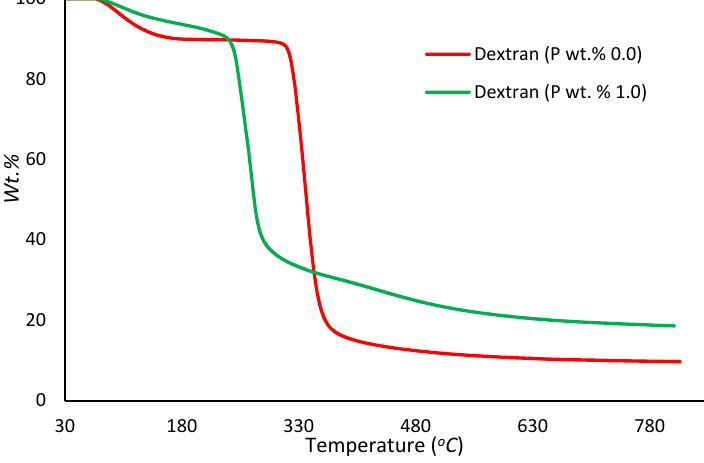
Figure 4. Thermograms of modified and unmodified versions of dextran at 60 ◦ C / min.